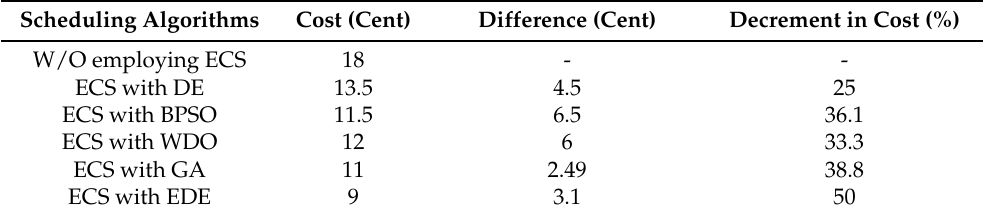
Figure 15. Net energy cost evaluation after scheduling noninterruptible appliances. Table 9. Numerical results of net energy cost minimization evaluation after scheduling noninterrupt- ible